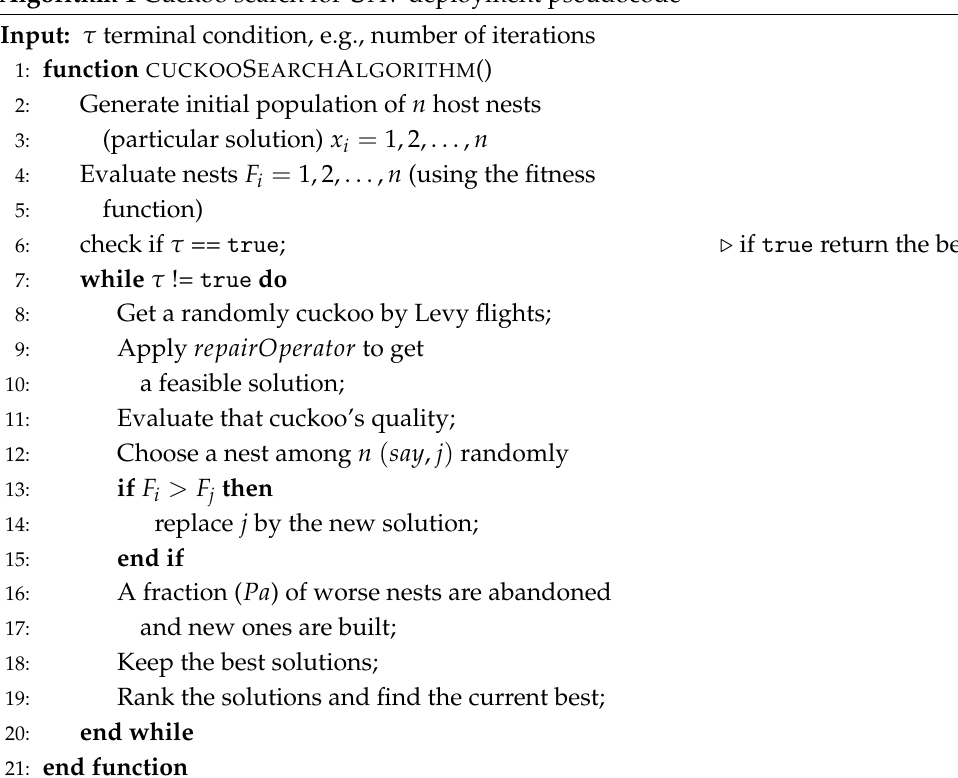
Algorithm 1 Cuckoo search for UAV deployment